Question: Produce a descriptive caption suitable for publication.
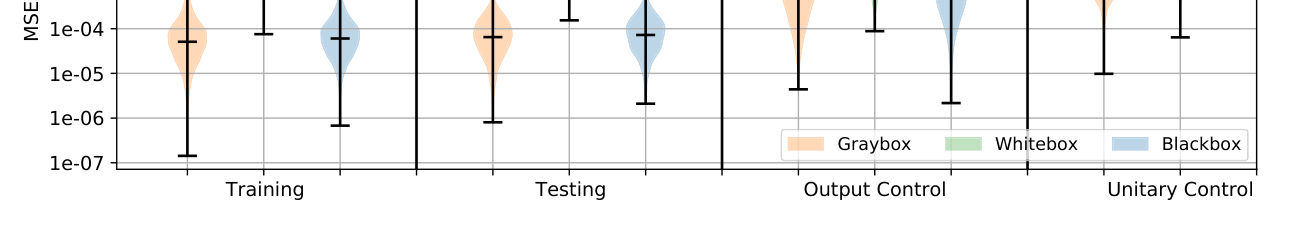
Answer: Experimental quantum control performance. The distribution of the fidelity between the experimentally measured output power distribution and the desired target distribution for the three models. The whitebox model utilizes a real-valued tri-diagonal Hamiltonian with linear dependence on voltages, in addition to fan-in and fan-out sections. The results are for (a) the output controller, and (b) the unitary controller. The reported values are the average over the three distributions corresponding to each possible initial state. (c) Violin plot showing the statistics of the MSE obtained for the training, testing, and control datasets. The horizontal lines represent from bottom to top, the minimum, median, and maximum respectively. The plot also shows an estimated kernel density for the data.